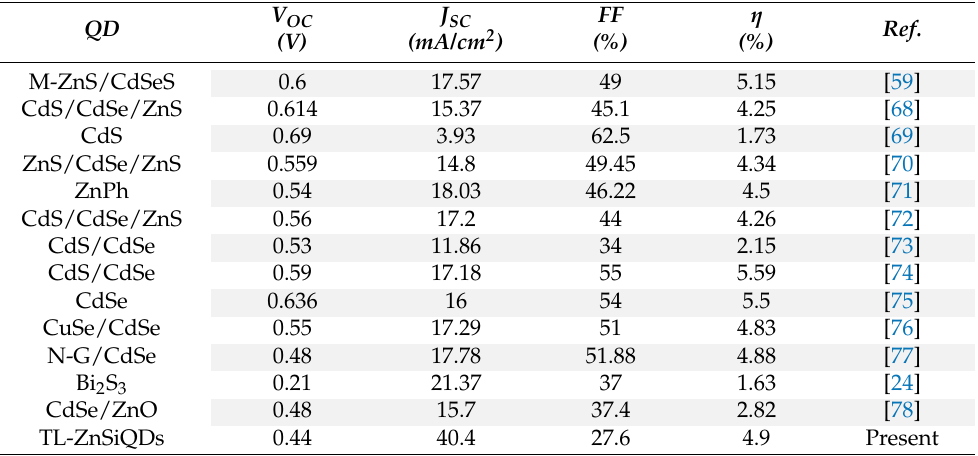
Table 4. Comparison of the performance of the proposed cells with other state-of-the-art literature